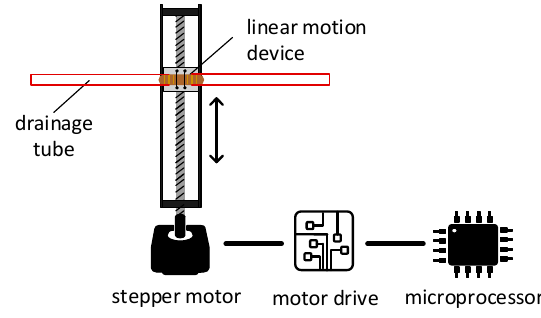
Figure 9. Line chattering module.